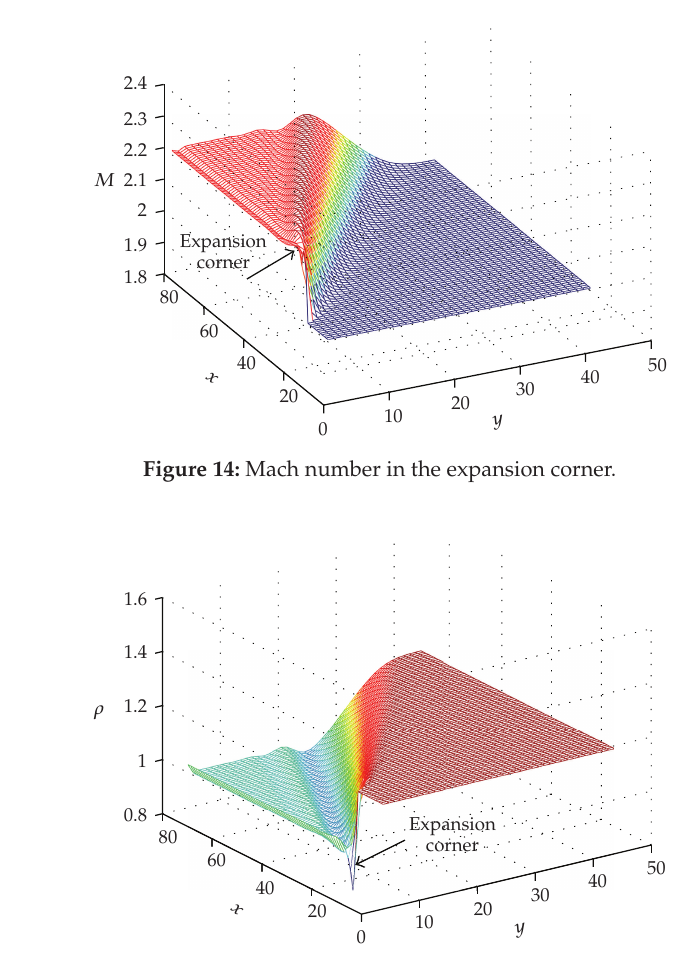
Figure 15: Density in the expansion